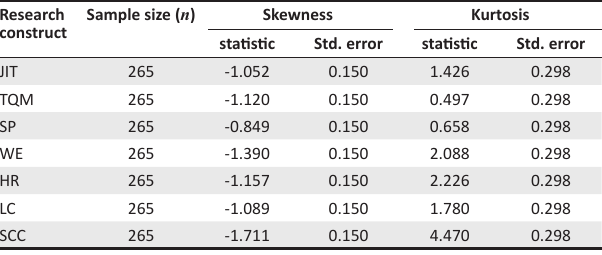
TABLE 3: Correlation analysis of the constructs. TABLE 2: Assessment of data